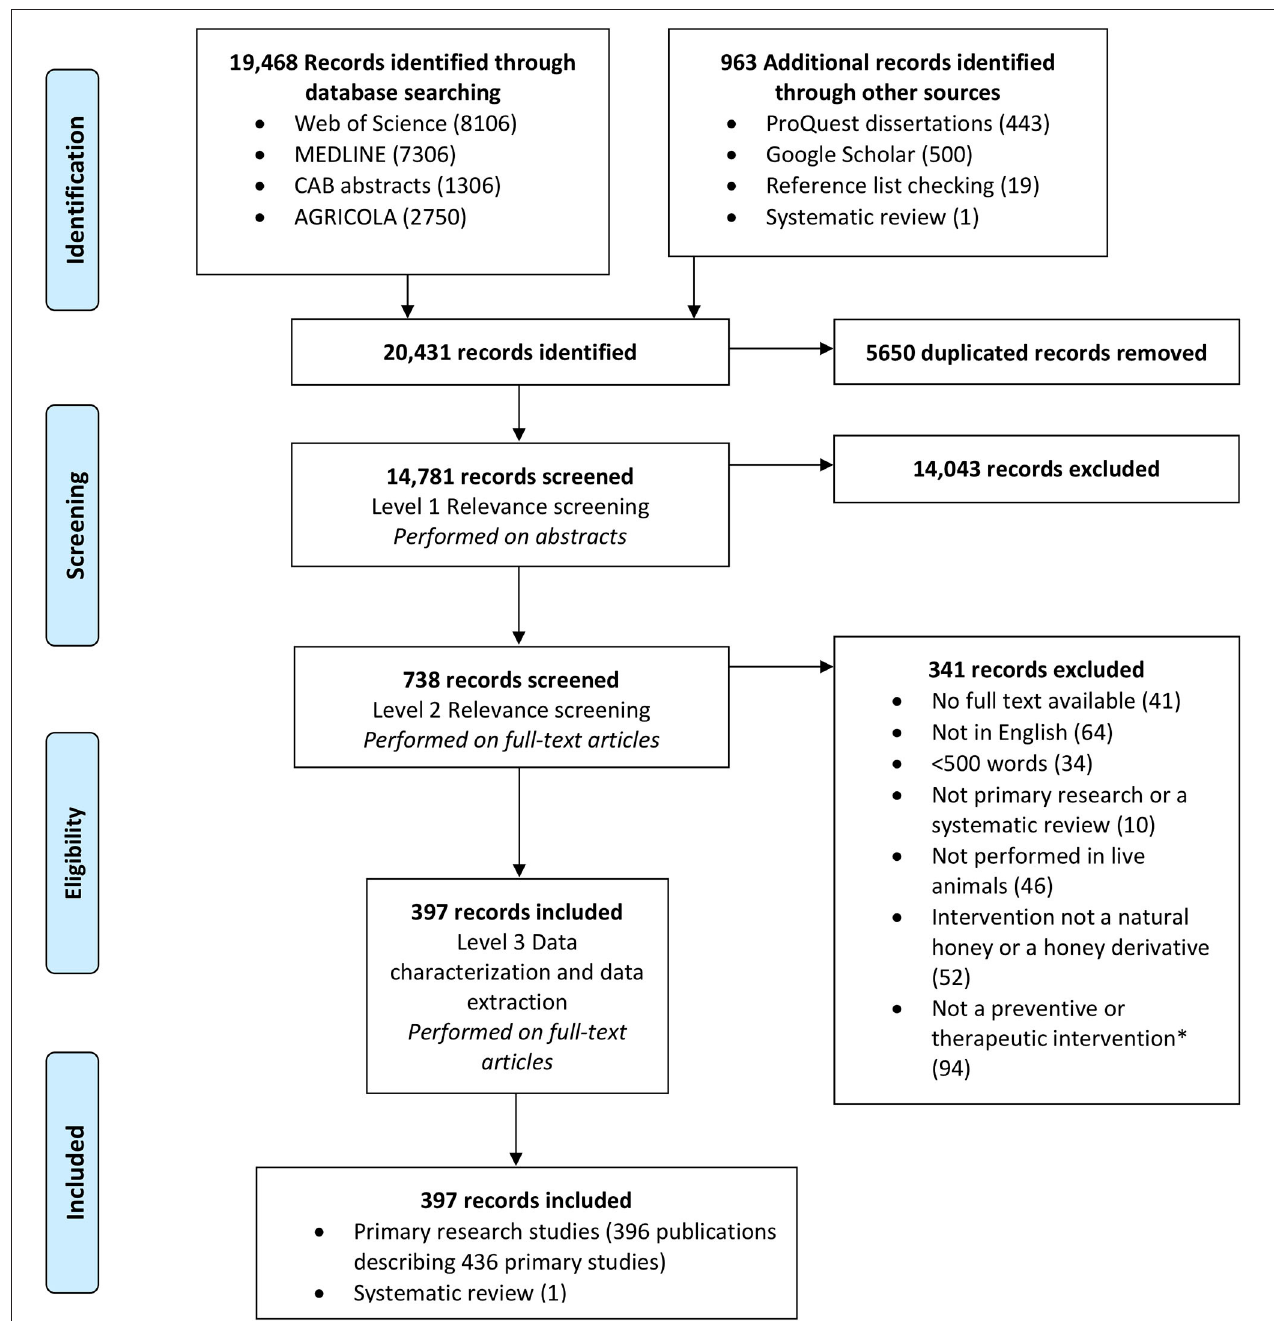
FIGURE 1 | PRISMA (preferred reporting items for systematic reviews and meta-analyses) flowchart showing the selection of studies eligible for a scoping review of the evidence for the medicinal use of natural honey in animals.